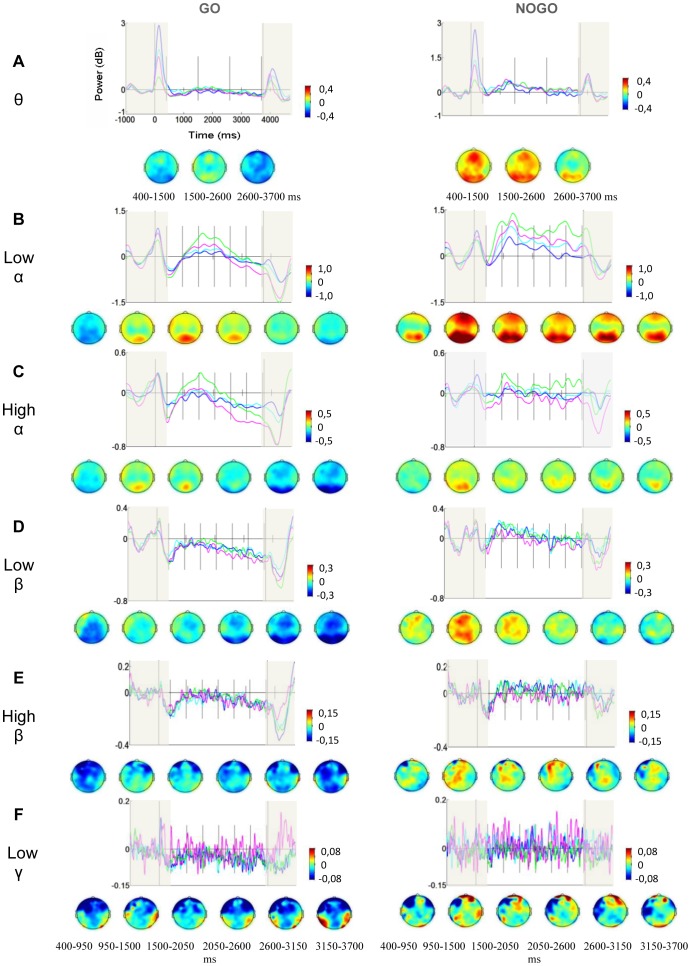
Go and NoGo activity for Event Related Spectral Perturbations.(A–F) Go and NoGo activity for theta, low alpha, high alpha, low beta, high beta and gamma. For all bands there is a Go/NoGo difference in power in the S1–S2 interval, with reduced power in the Go compared to the NoGo condition. The colors of the ERSPs indicate the region of interest that each ERSP represents; frontal (cyan), central (blue), parietal (green) and occipital (magenta) (illustrated in figure 1A). Theta scalp topographies represent average activity within 3 post S1 time intervals; alpha, beta and gamma topographies within 6 intervals, indicated with vertical lines in the time-power plots. Intervals not included in the analysis are shaded.